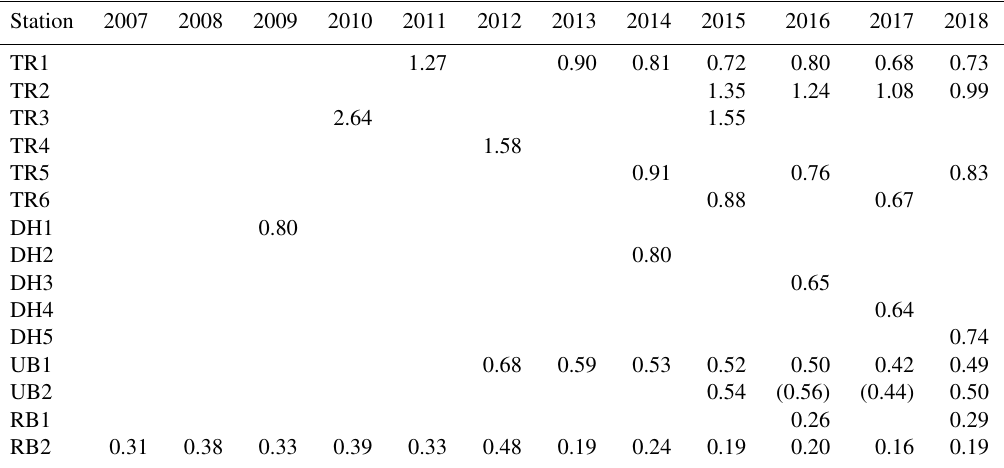
Figure 1. Location of the stations and density of the detached houses. Differently colored markers indicate different station categories. The central urban area is marked on the map with an orange circle. Table 1. Annual mean values of eBC concentration for each station (in units of µgm − 3 ). The annual means at UB2 in 2016–2017 are bracketed since there was less than 50% of valid